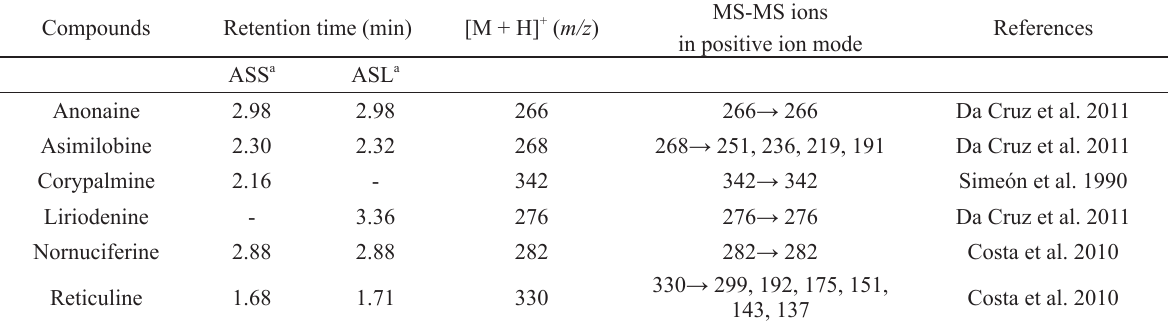
Compounds identified in the Annona squamosa extracts by UPLC-ESI-MS/MS analysis. Compounds